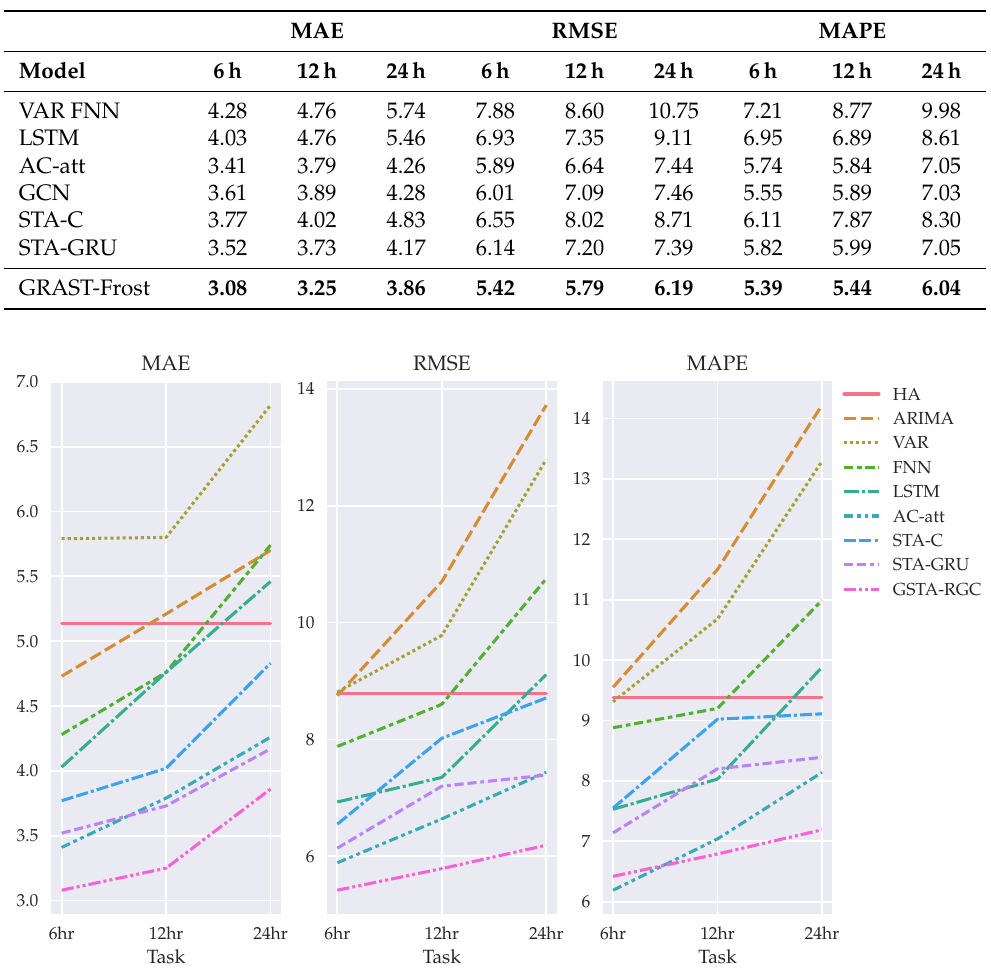
Figure 6. MAE, MAPE, and RSME metric results for temperature forecasting on 6, 12, and 24 h in